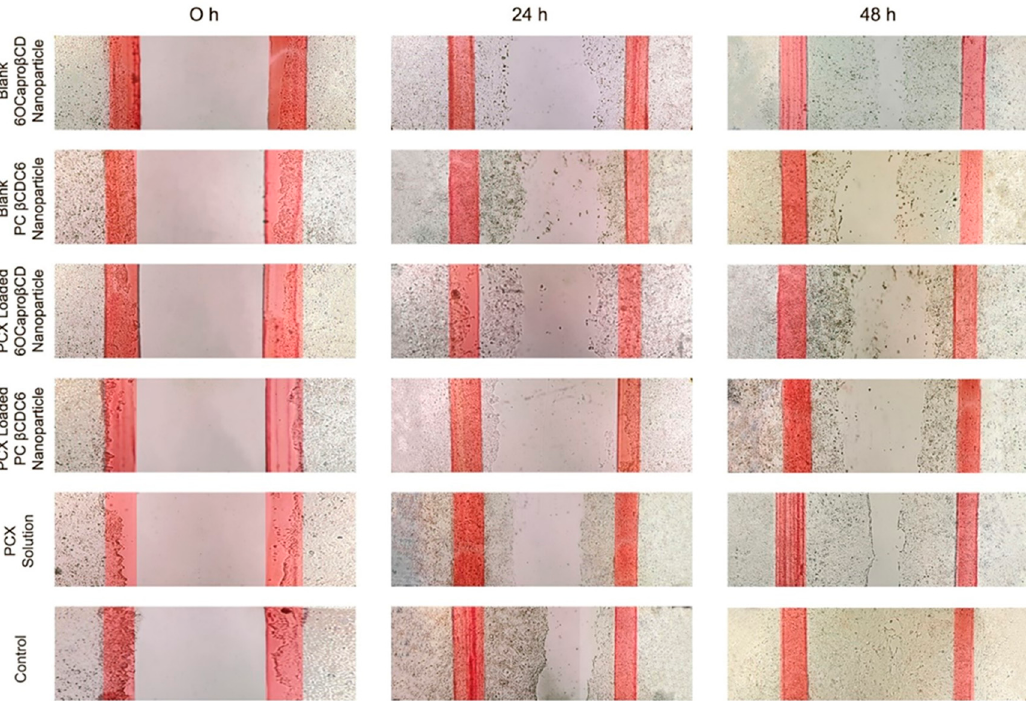
Figure 4. Suppression of migration and invasion of 4T1 murine breast cancer cells by blank or paclitaxel-loaded amphiphilic cyclodextrin nanoparticles in vitro. Wound-healing assay of 4T1 cells before and after blank nanoparticles, drug-loaded nanoparticles, paclitaxel solution, or complete DMEM treatment of up to 48 h.